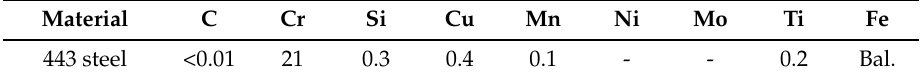
Table 1. Chemical composition of the steel plate (typical value, wt. %). Table 2. Mechanical properties of 443 stainless steel.